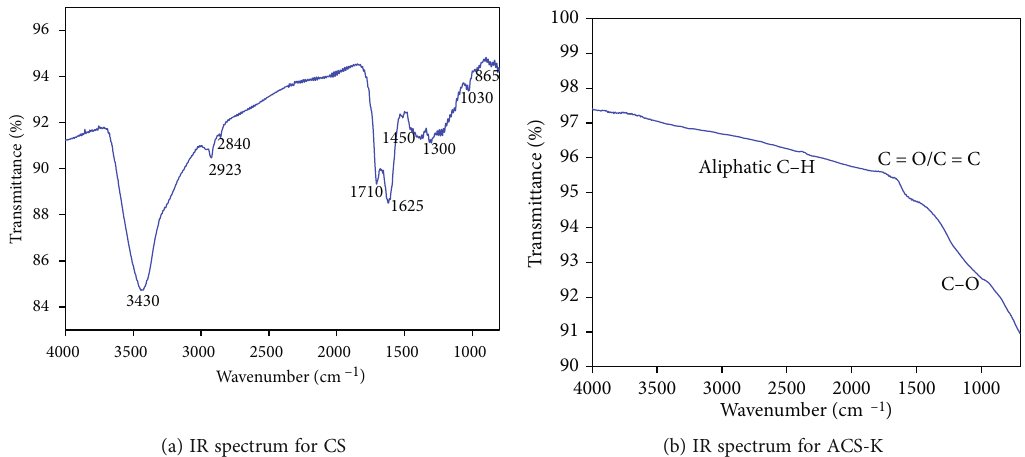
Figure 4: (a, b) FTIR analysis for CS and ACS-K showing variation in the presence of functional